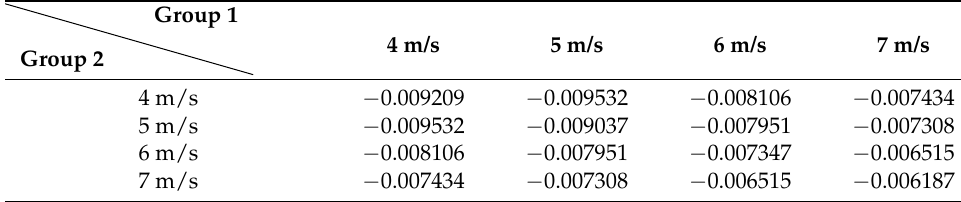
Table A7. Damping coefficient for TM2 of SG under different operating conditions.